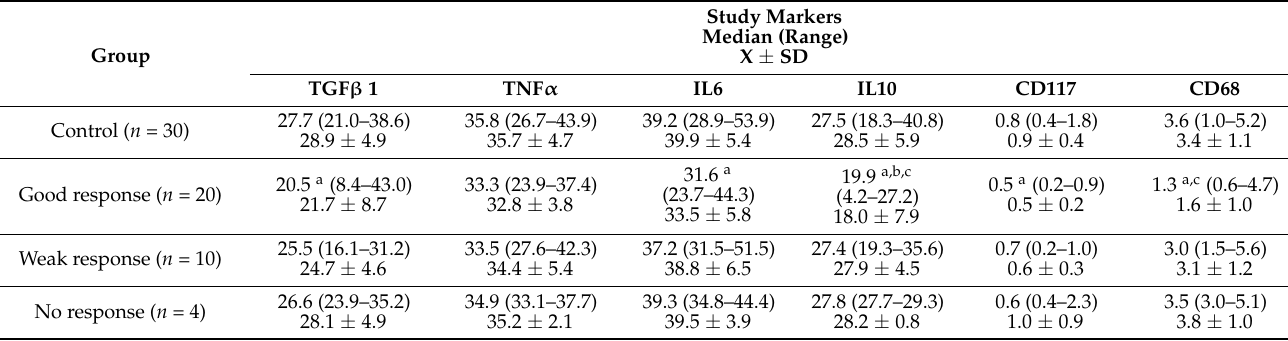
Table 2. The percentage of TGF β 1, TNF α , IL6, IL10, CD117, and CD68-positive cells in fibroids in the control group and study groups after 3 months of treatment with ulipristal acetate